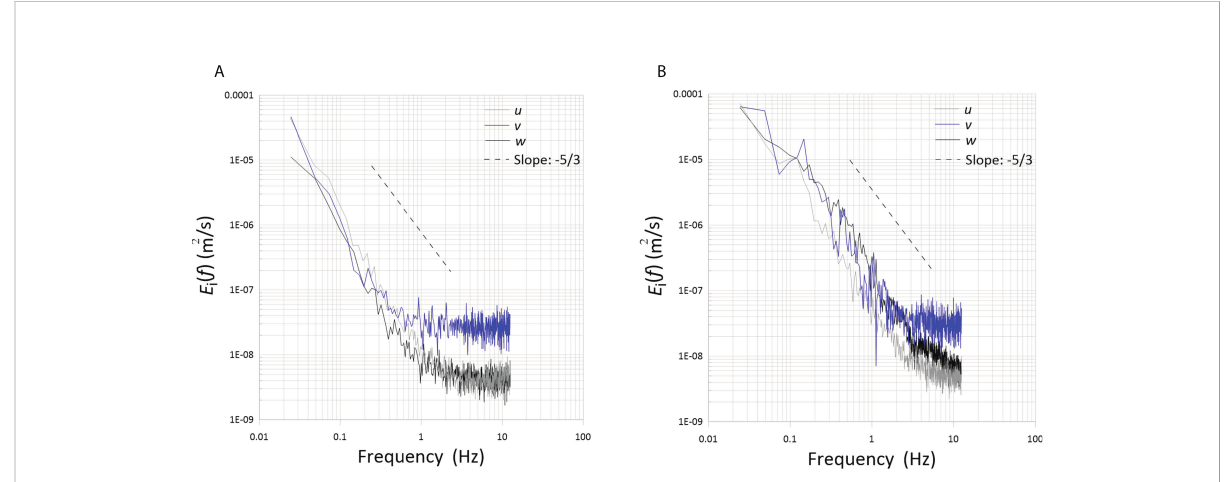
FIGURE 3 Power spectra of the fl uctuating velocities measured with pangasius at two abundances of (A) 50 and (B) 150 animal/m 3